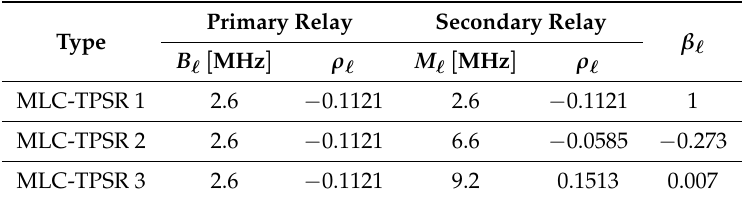
Figure 3. Cross-correlation coefficient (CC) and inter-relay CCC (IR-CCC) values according to separating bandwidth. Table 1. Parameters of separating bandwidth pairs for each multiple linear chirp